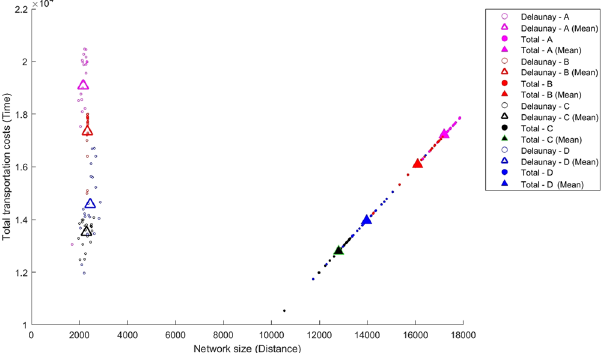
Figure 3. Total transportation costs for a region with 12 towns for different node distributions and preexisting connecting networks. Empty symbols: Delaunay triangulation. Filled symbols: Complete network. Node configurations: circunference (magenta), circunference with a center (red), double circunference with a center (black) and random (blue). Smaller symbols correspond to individual realizations, larger symbols to the mean for each case (preexisting network/geographical